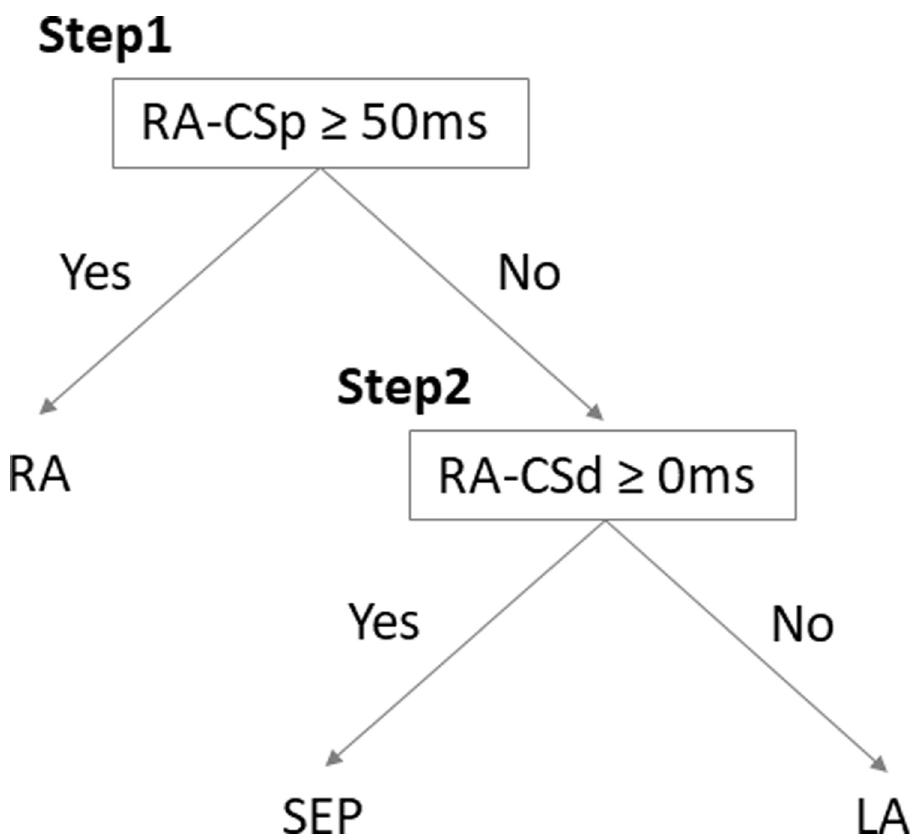
Fig 4. An algorithm to differentiate the areas of non-PV triggers. RA-CSp, intra-atrial activation interval from the earliest in RA to proximal CS; RA-CSd, intra-atrial activation interval from the earliest in RA to distal CS; RA, right atrium; SEP, atrial septum; LA, left atrium; CS, coronary sinus.